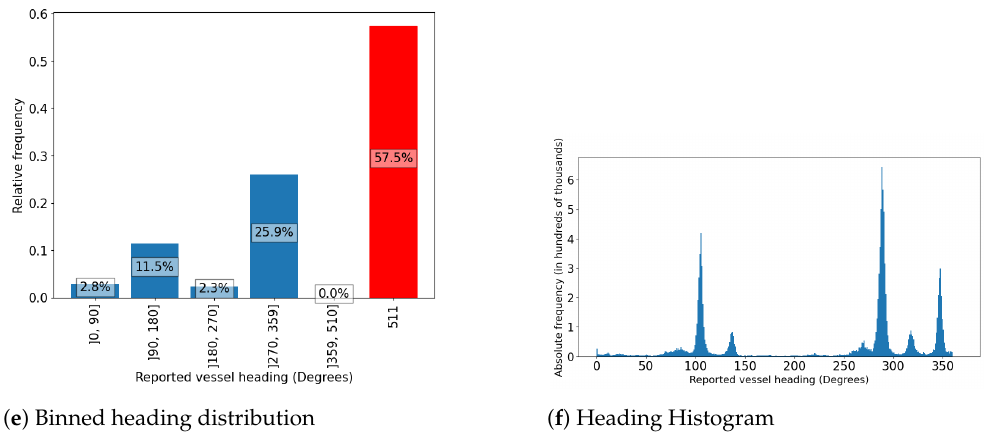
Figure 2. Univariate dataset distribution analysis for the month of June 2018.